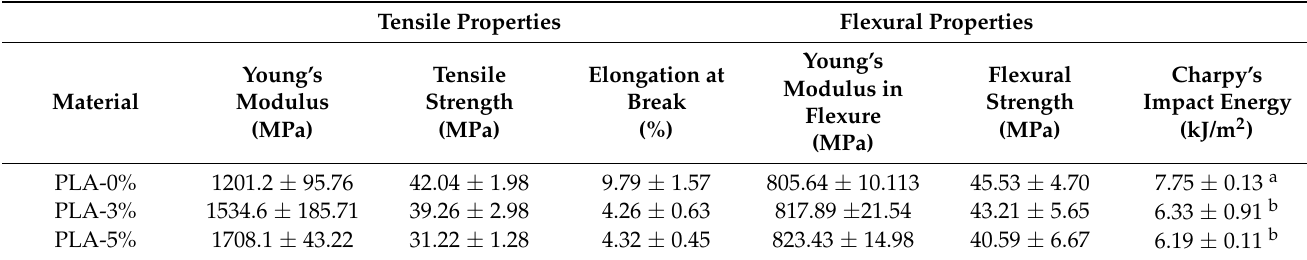
Table 3. Tensile, flexural, and impact-resistance properties and area of tensile stress–strain curve (Toughness) of 3-D printed neat PLA, PLA-3%, and PLA-5%CaCO 3